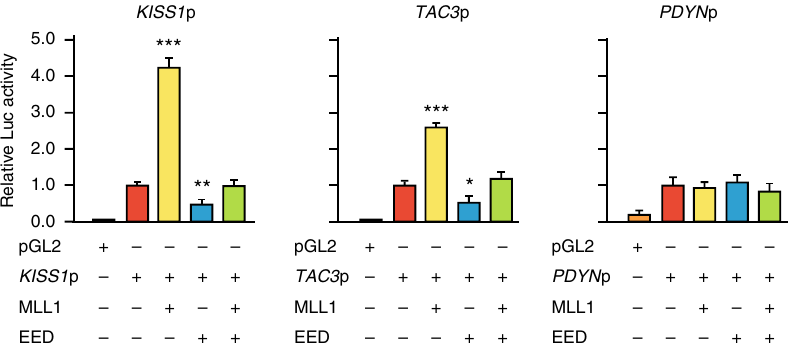
Fig. 4 Effect of MLL1 and EED on KISS1 , TAC3 , and PDYN promoter (p) activity. Bars represent mean ± s.e.m. ( n = 6). *** P < 0.001 vs. all other groups; ** P < 0.01 vs. Kiss1 promoter alone; * P < 0.05 vs. Tac3 promoter alone; one-way ANOVA followed by SNK